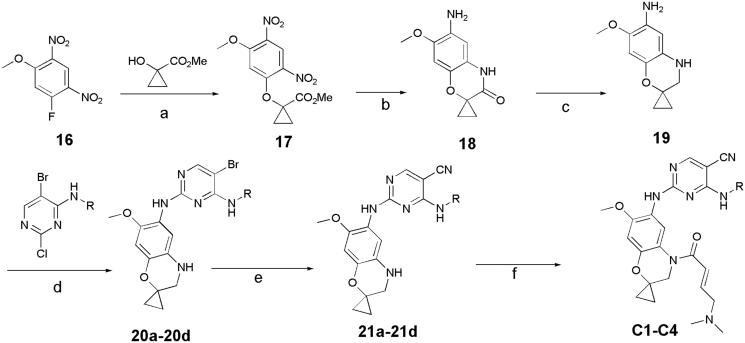
Synthesis of C1-C4, Reagents and conditions: (a) Cs2CO3, MeCN, rt, 2 h; (b) Fe/NH4Cl, MeOH, H2O,70 °C,12h; (c) LAH, THF, 70 °C, 2 h; (d) pTSA, Dioxane, 100 °C, 2 h; (e) Zn(CN)2, Pd2(dba)3.CHCl3/dppf, DMF, H2O, 120 °C(MW), 1.5 h; (f) (E)-4- (dimethylamino)but-2-enoyl chloride, TEA, 40 °C, 2 h.